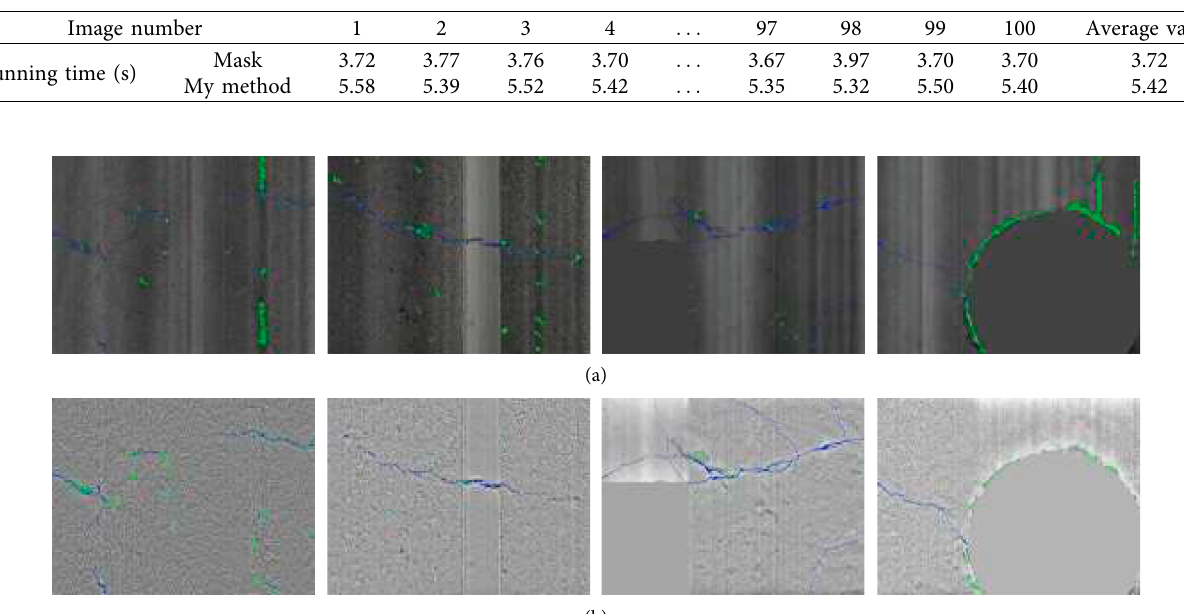
Figure 9: Crack segmentation by the minimal path method from (a) the original image; (b) the image after dodging. (The blue area is the accurately segmented crack; the green is the pseudo cracks.).